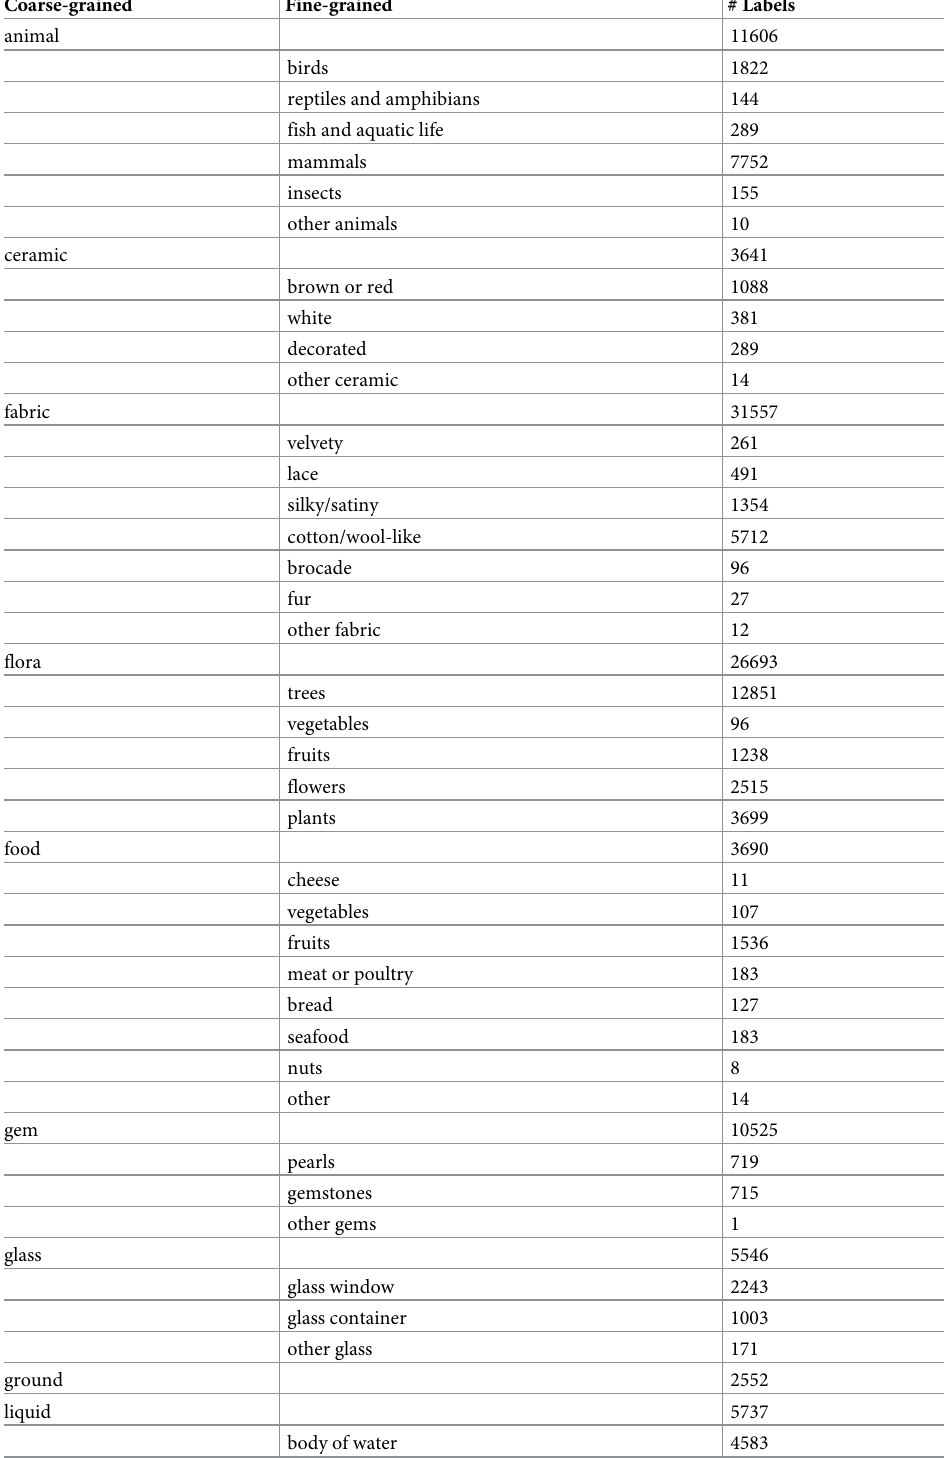
Table 2. The number of annotated bounding boxes for each coarse- and fine-grained category. Note that not every bounding box is associated with a fine-grained label since participants were not always able to arrive at a consensus. See main text for